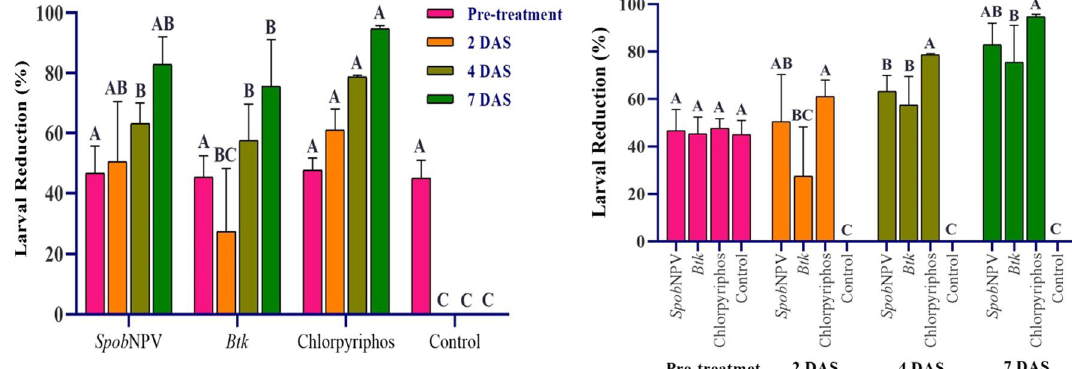
Fig. 6 Spilosoma obliqua third instar larvae reduction percentage at 2, 4 and 7 days after imposing of treatments. DAS Days after